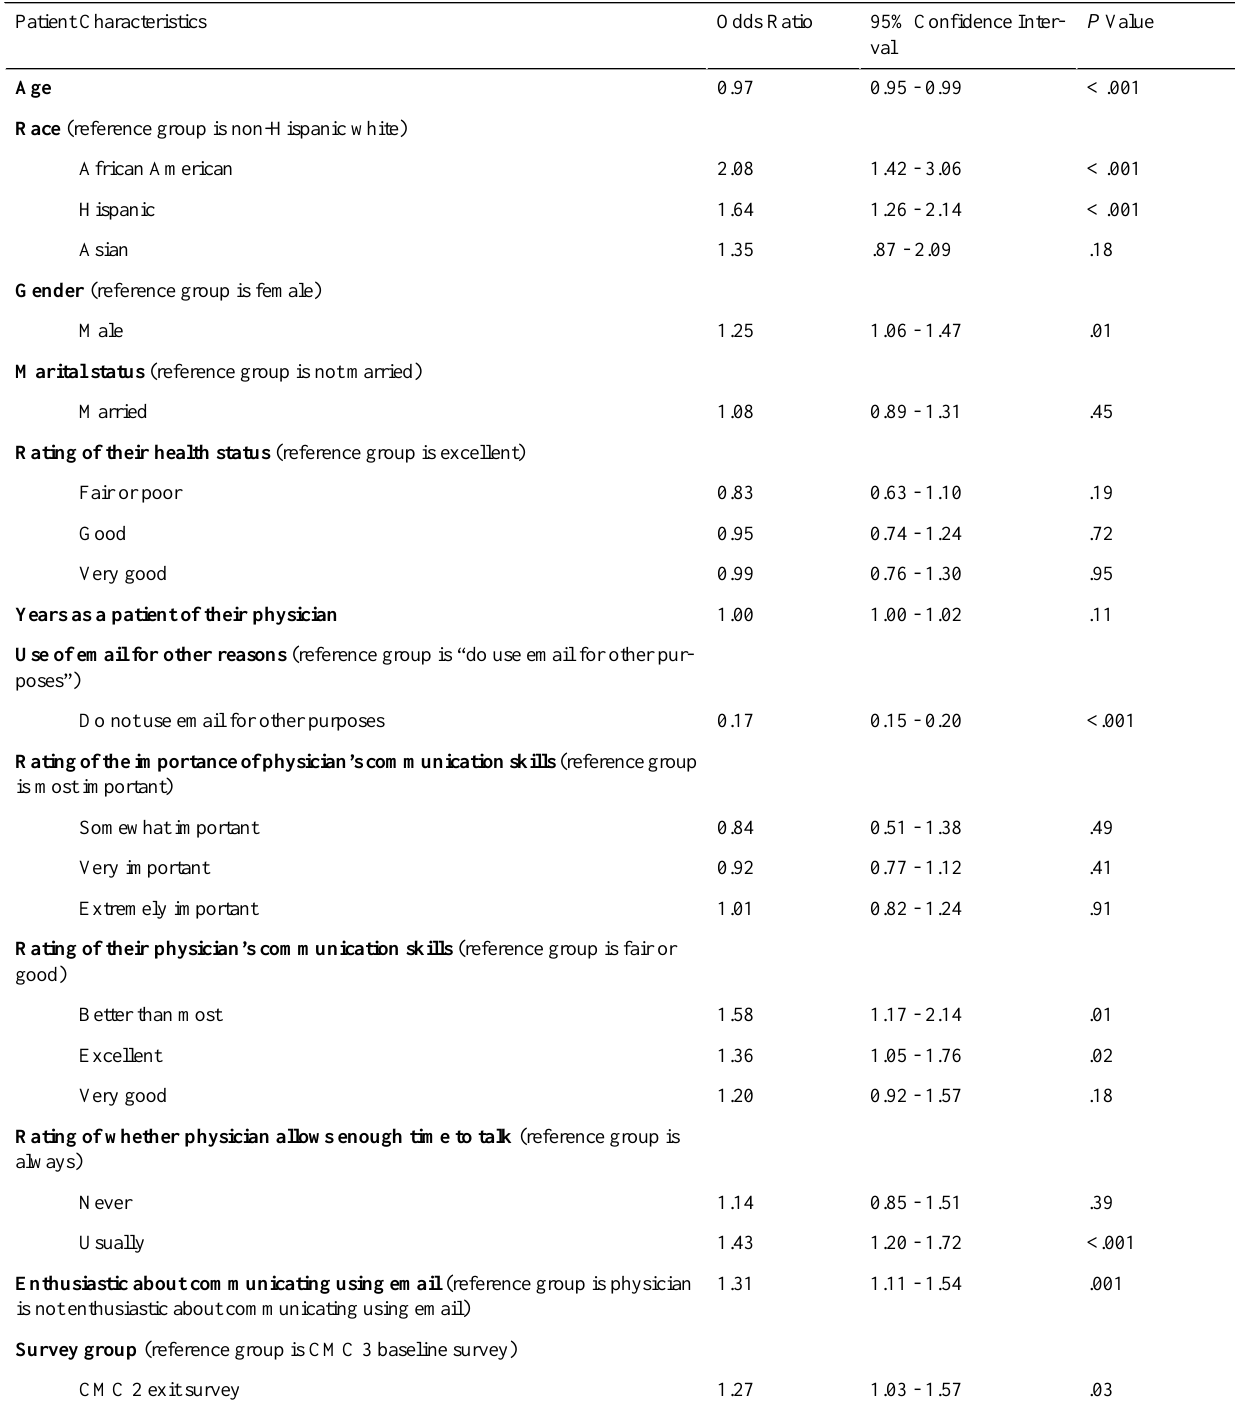
Table 2. Logistic regression analysis of patient enthusiasm to use email in 2003 (all patient characteristics were significant in univariate